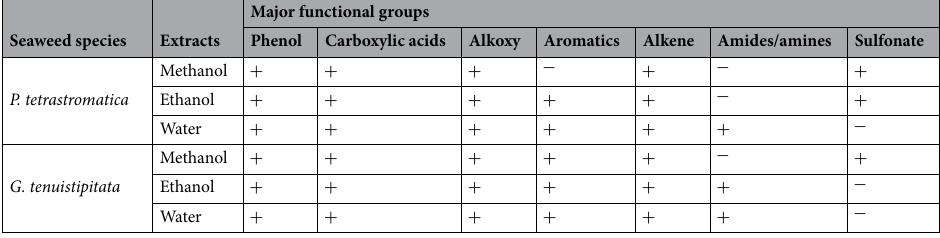
Table 2. Major functional groups of active components based on the peak value of Fourier transform infrared. “+” constituent’s existence, “−” constituent’s